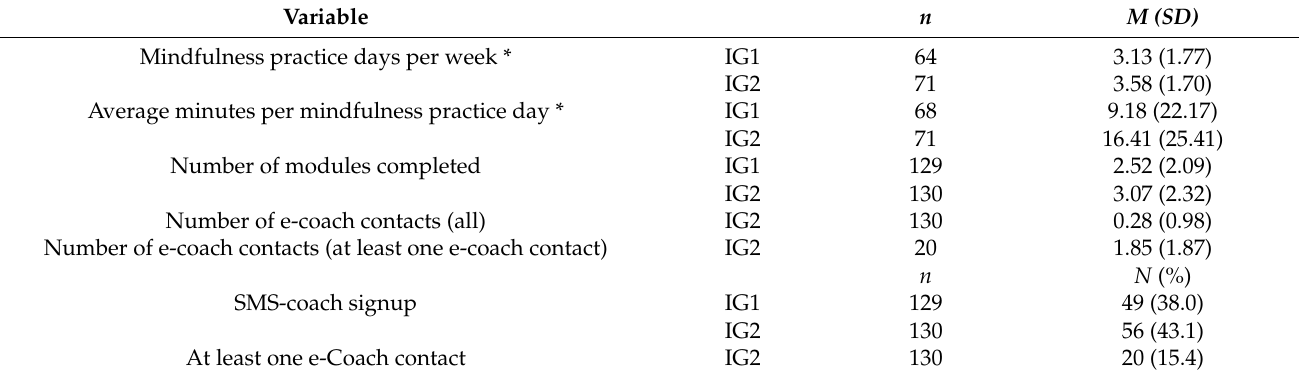
Table 5. Descriptive overview of guidance and adherence-associated